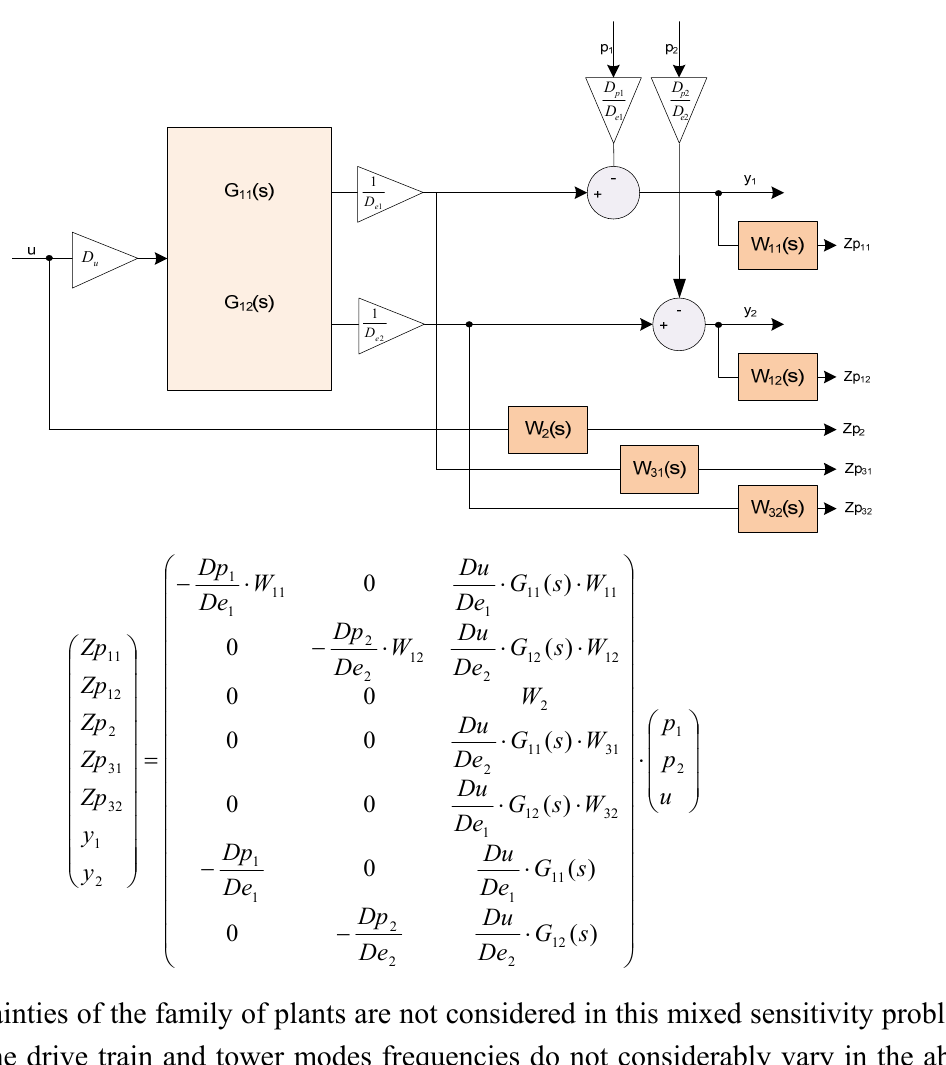
Figure 6. Augmented plant for the MISO Mixed-Sensitivity